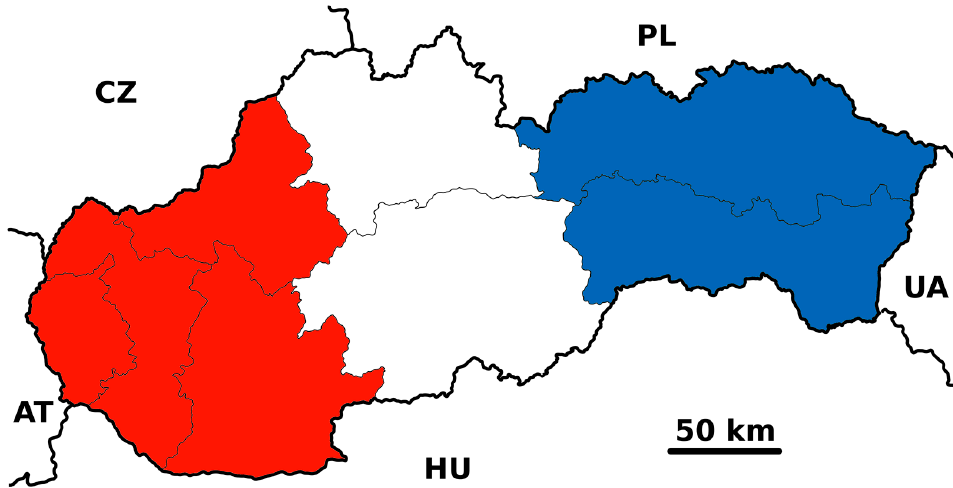
Figure 3. Division of the Slovak Republic according to electricity distributors.